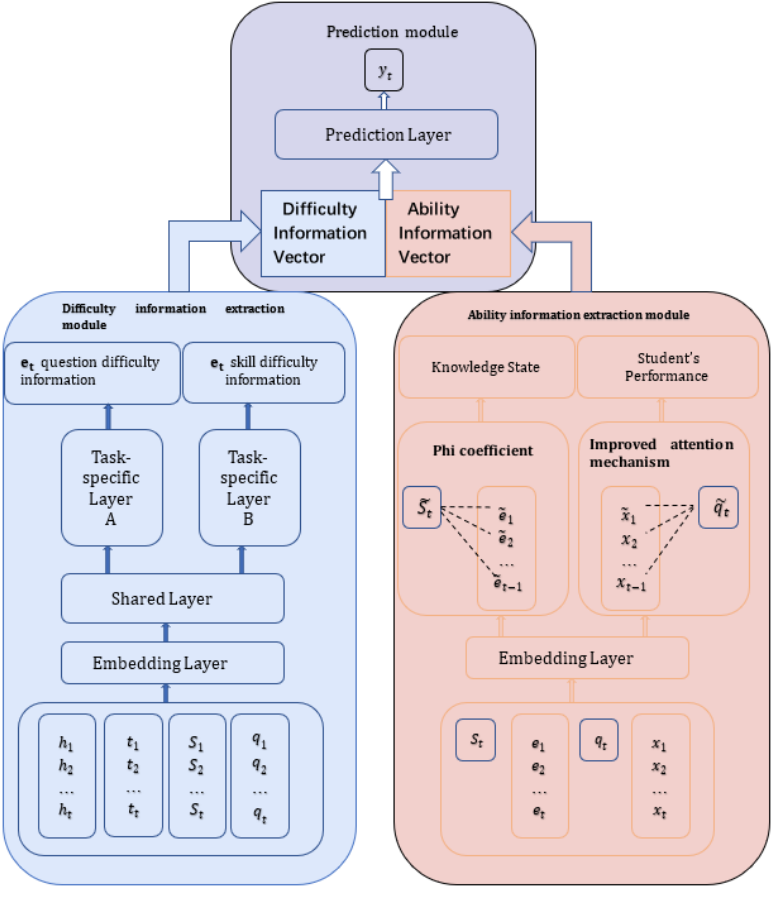
Figure 1. Model structure